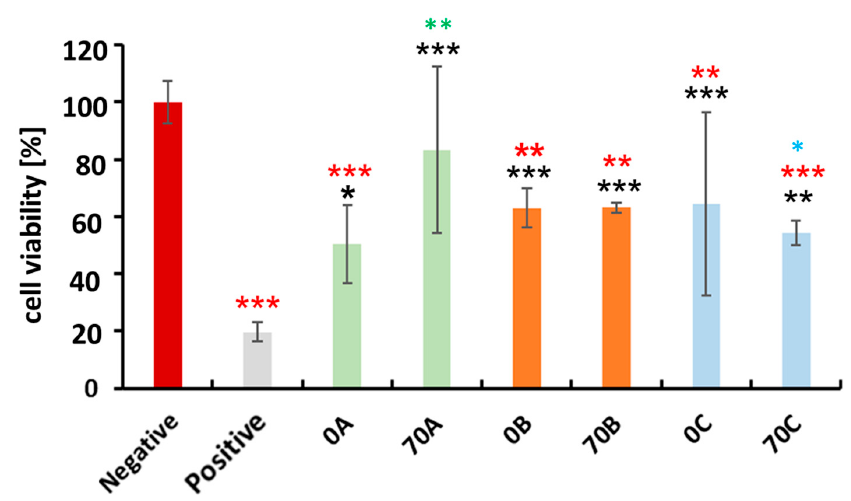
Figure 6. Human breast adenocarcinoma (MDA-MB-231) cytocompatibility with 0A , 70A , 0B , 70B, and 0C , 70C chitosan–cellulose hydrogel beads over the timeframe of 48 h. Values are expressed as percentage of the means ± SD ( n = 4). Statistical significance was defined as * p < 0.05, ** p < 0.01, *** p < 0.005 compared to control samples (ANOVA test). Black * and red * indicates sample comparison to positive and negative control respectively. While green * shows comparison between 0A and 70A , 0B and 70B , 0C and 70C ; blue * shows between 70A and 70B , 70A and 70C , 70B and 70C .